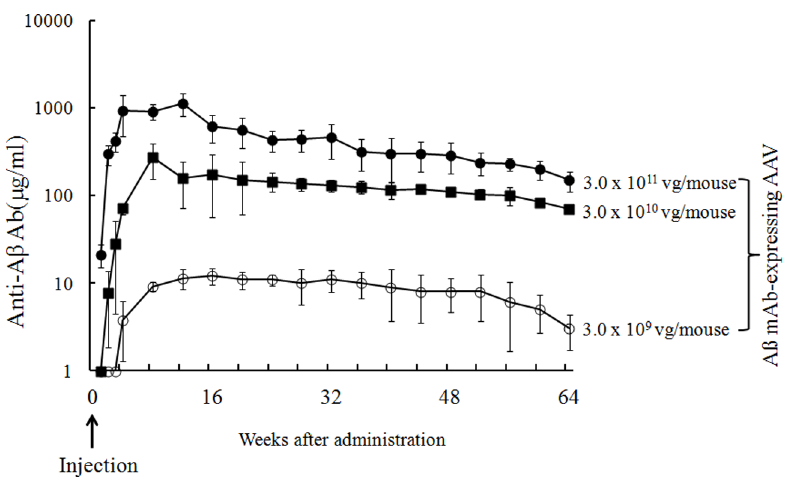
Figure 4. Kinetics of anti-Aß Ab production by mice injected with Aß mAb-expressing AAV. Normal C57BL/6 mice (n=10/group) received a single intramuscular injection with 3.0 6 10 9 , 3.0 6 10 10 , 3.0 6 10 11 vg of Aß mAb-expressing AAV or 3.0 6 10 11 vg of LacZ-expressing AAV vector. The titer of IgG1 Ab binding to Aß1–42 was detected at indicated time points. Significant difference among groups received 3 6 10 9 , 3 6 10 12 and 3 6 10 11 vg of Aß mAb-expressing AAV was observed from 2-week to 64-week after administration (P , 0.05). Data are presented as mean 6 SE.